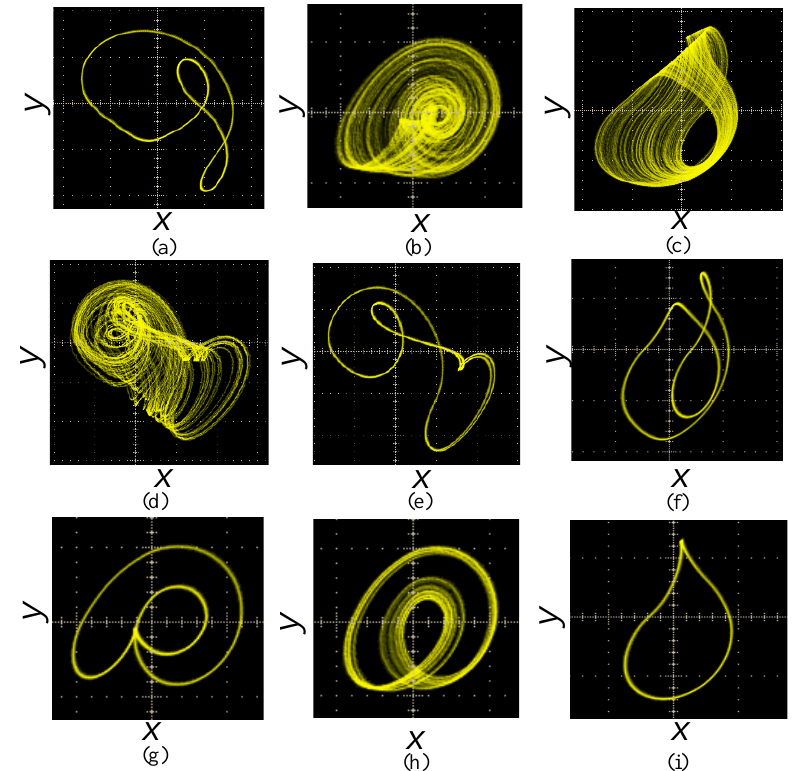
Figure 14. Multiple coexisting attractor with different initial values: ( a ) (1 1 1 6); ( b ) (1 1 1 − 2.7); ( c ) (1 1 1 7); ( d ) (1 1 1 2); ( e ) (1 1 1 1); ( f ) (1 1 1 − 6); ( g ) (1 1 1 − 2); (h ) (1 1 1 − 4); ( i ) (1 1 1